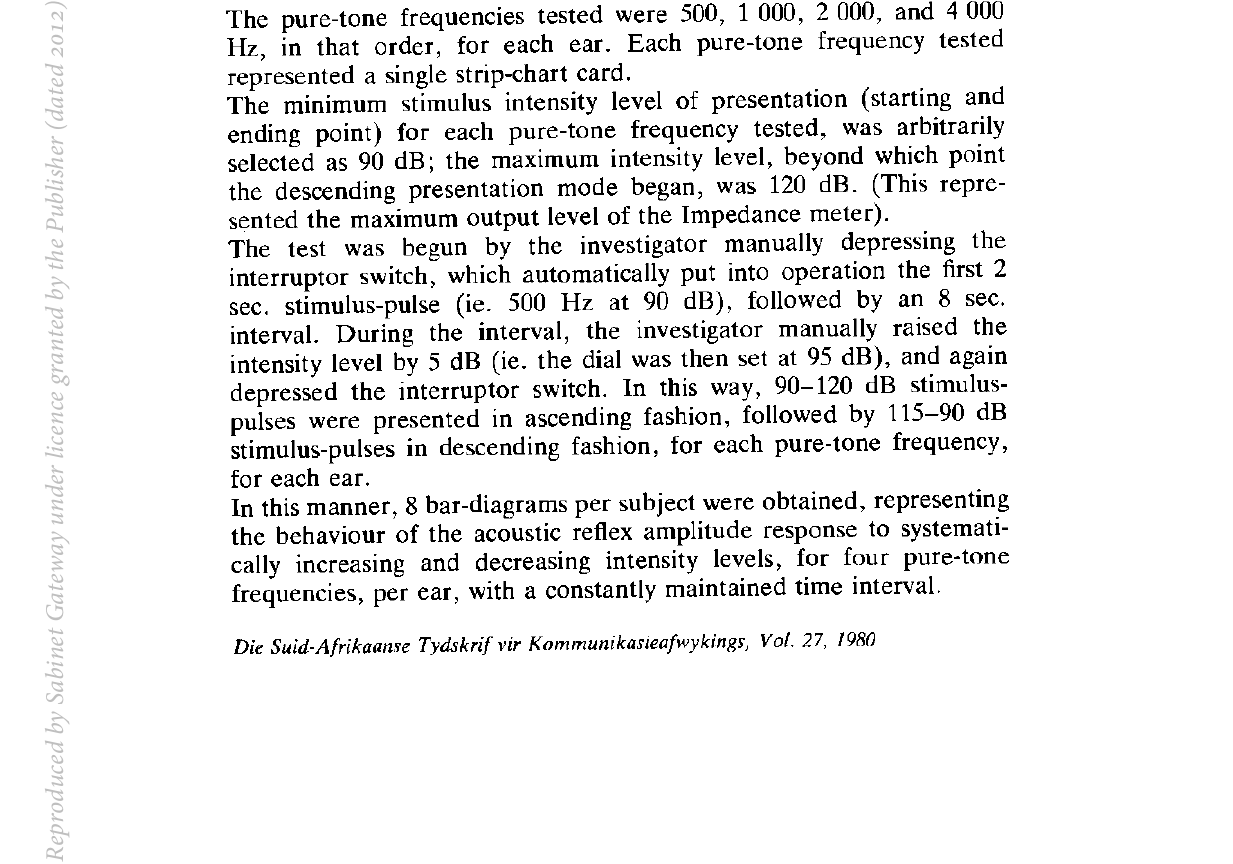
Figure 3. Example of the acoustic reflex amplitudes at different intensity levels for 100Hz pure-tone stimulus